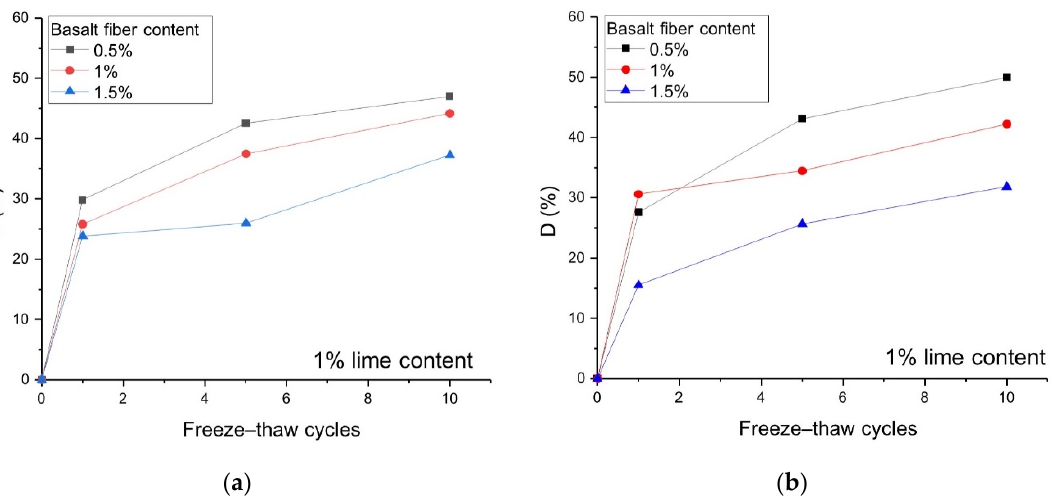
Figure 9. Effects of fiber content and length on the freeze–thaw damage D with 1% lime content: ( a ) L = 6 mm and LC = 1%; ( b ) L = 12 mm and LC = 1%.